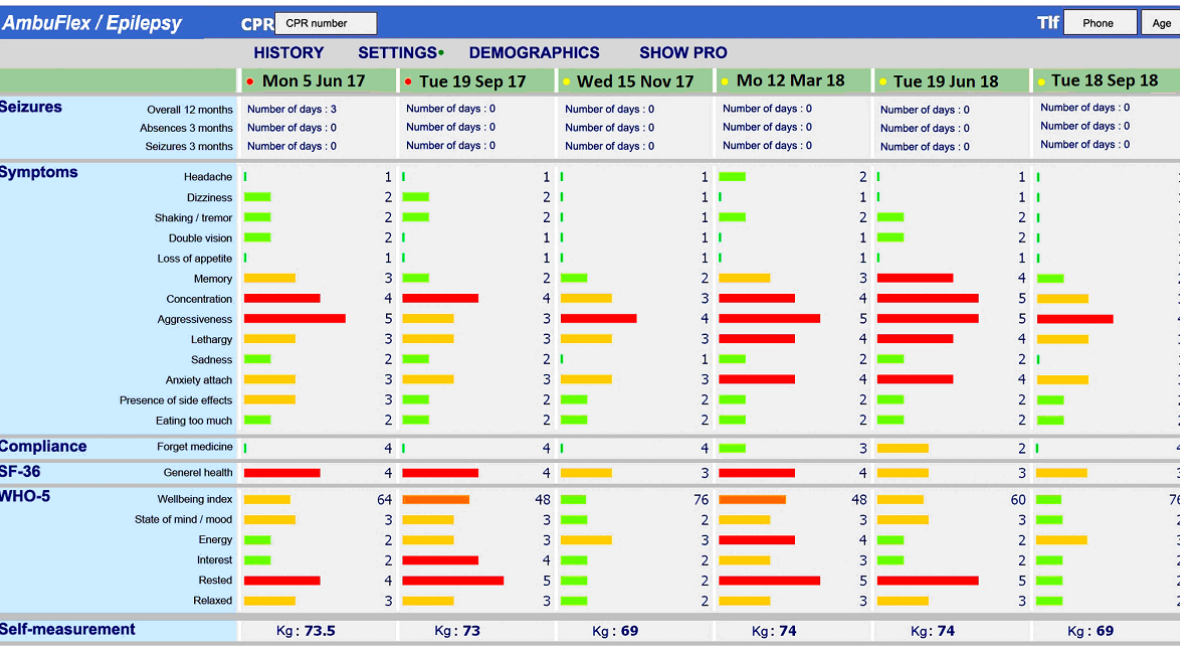
Figure 1. Example of the symptom overview in AmbuFlex/Epilepsy. The bar color and length both indicate the severity of the symptom (translated from